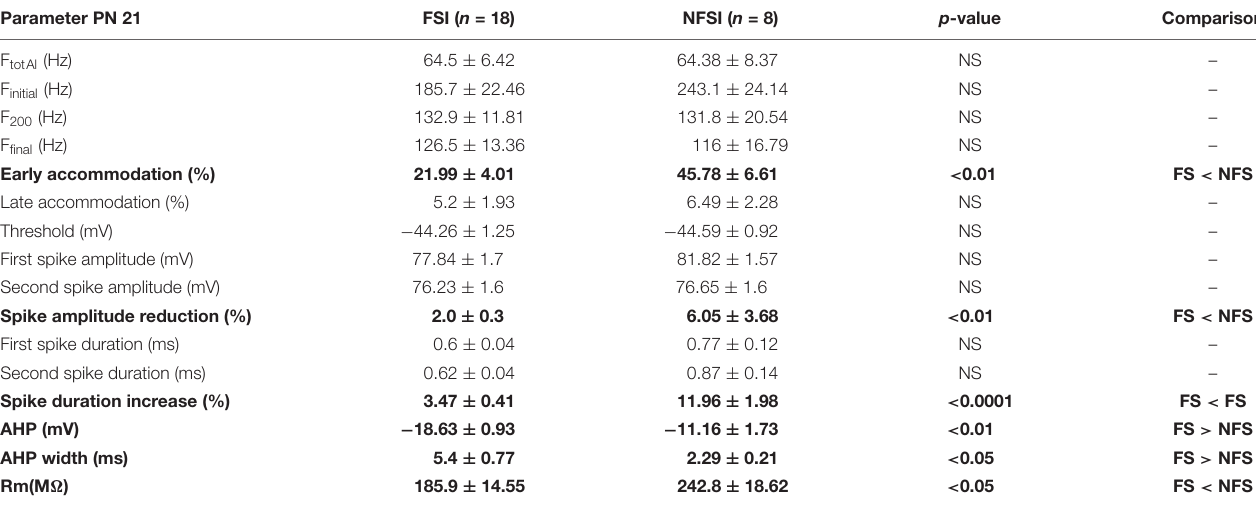
TABLE 2 | Electrophysiological properties of FSI and NFSI at PN21 in Nkx2.1 Cre :ChR2-YFP Lox / + mice. Parameter PN